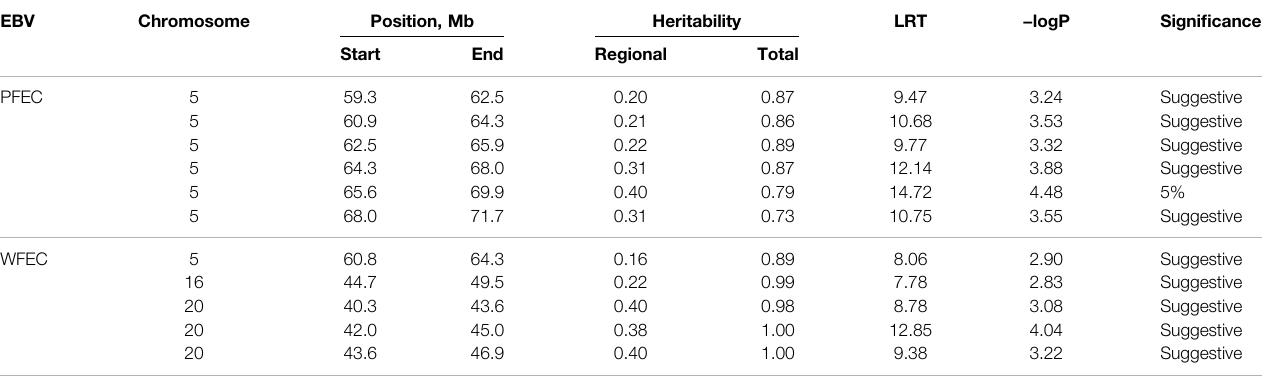
TABLE 2 | Summary statistics of the regional heritability analysis using 500-SNP windows. EBV